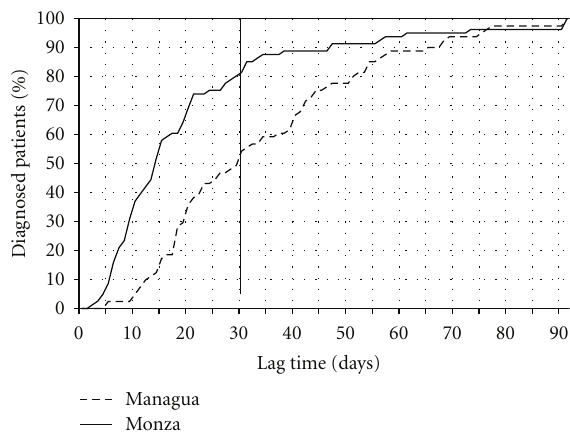
Figure 1: Lag time to diagnosis in days: cumulative